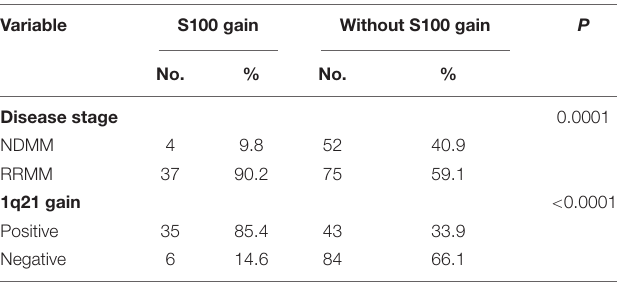
TABLE 1 | Correlation of S100 gain with disease stage and 1q21 gain in 168 MM patient